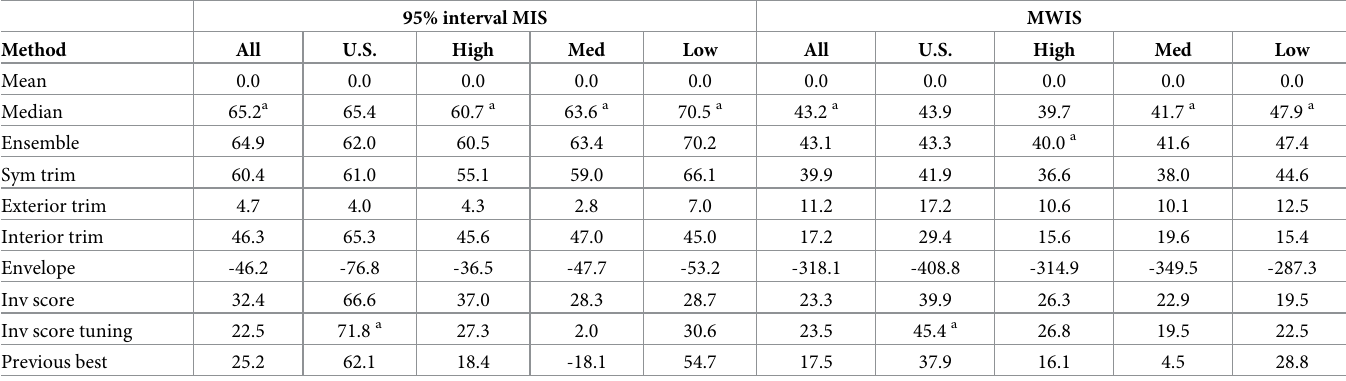
Table 8. For cumulative mortality, skill scores for 95% interval MIS and MWIS for the 78-week out-of-sample period.